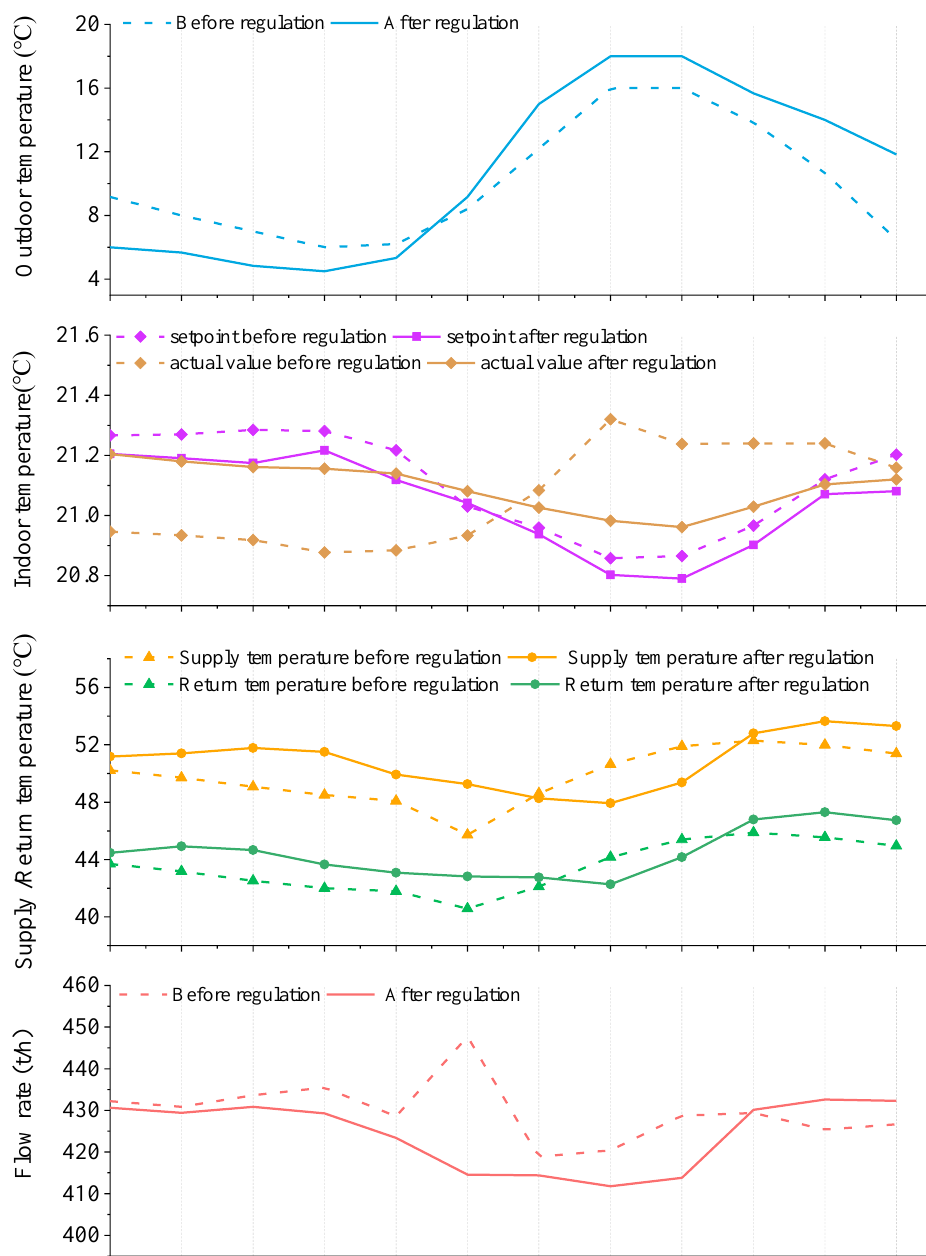
Figure 12. Variation curves of main heating parameters for two operating strategies. After regulation, the secondary-water-supply temperature changes in an approxi- mately opposite way with respect to that of the outdoor temperature, which is consistent with the change law of the indoor-temperature set point, and the change range is 47.9 ~ 53.7 °C. The flow-rate variation is 411.8 ~ 432.6 t/h, and the average flow is 424.4 t/h. In addition, the user-set indoor-temperature rule after regulation is similar to that before regulation, and users have a certain energy-saving behavior. The variation law of the ac- tual user indoor temperature after regulation is close to the set point, and the deviation is small, in the range − 0.1 ~ 0.2 °C, which proves that the proposed regulation strategy can better meet user demand for heating on demand.